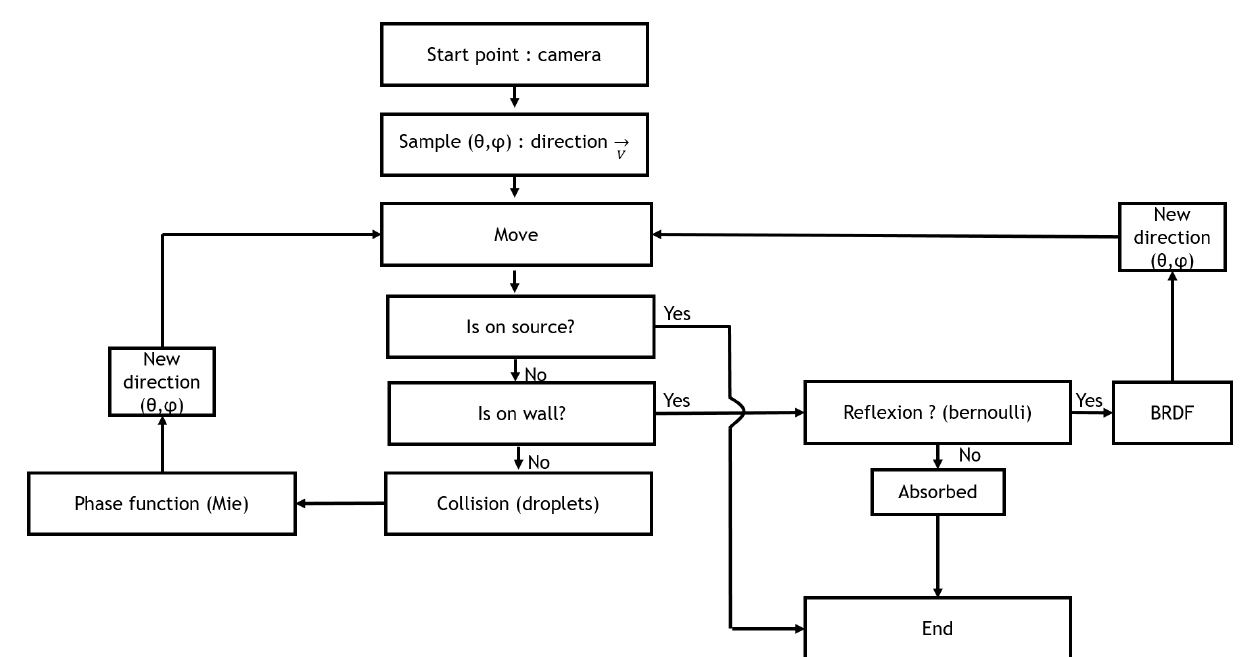
Figure 3. Diagram of the radiative transfer equation simulation